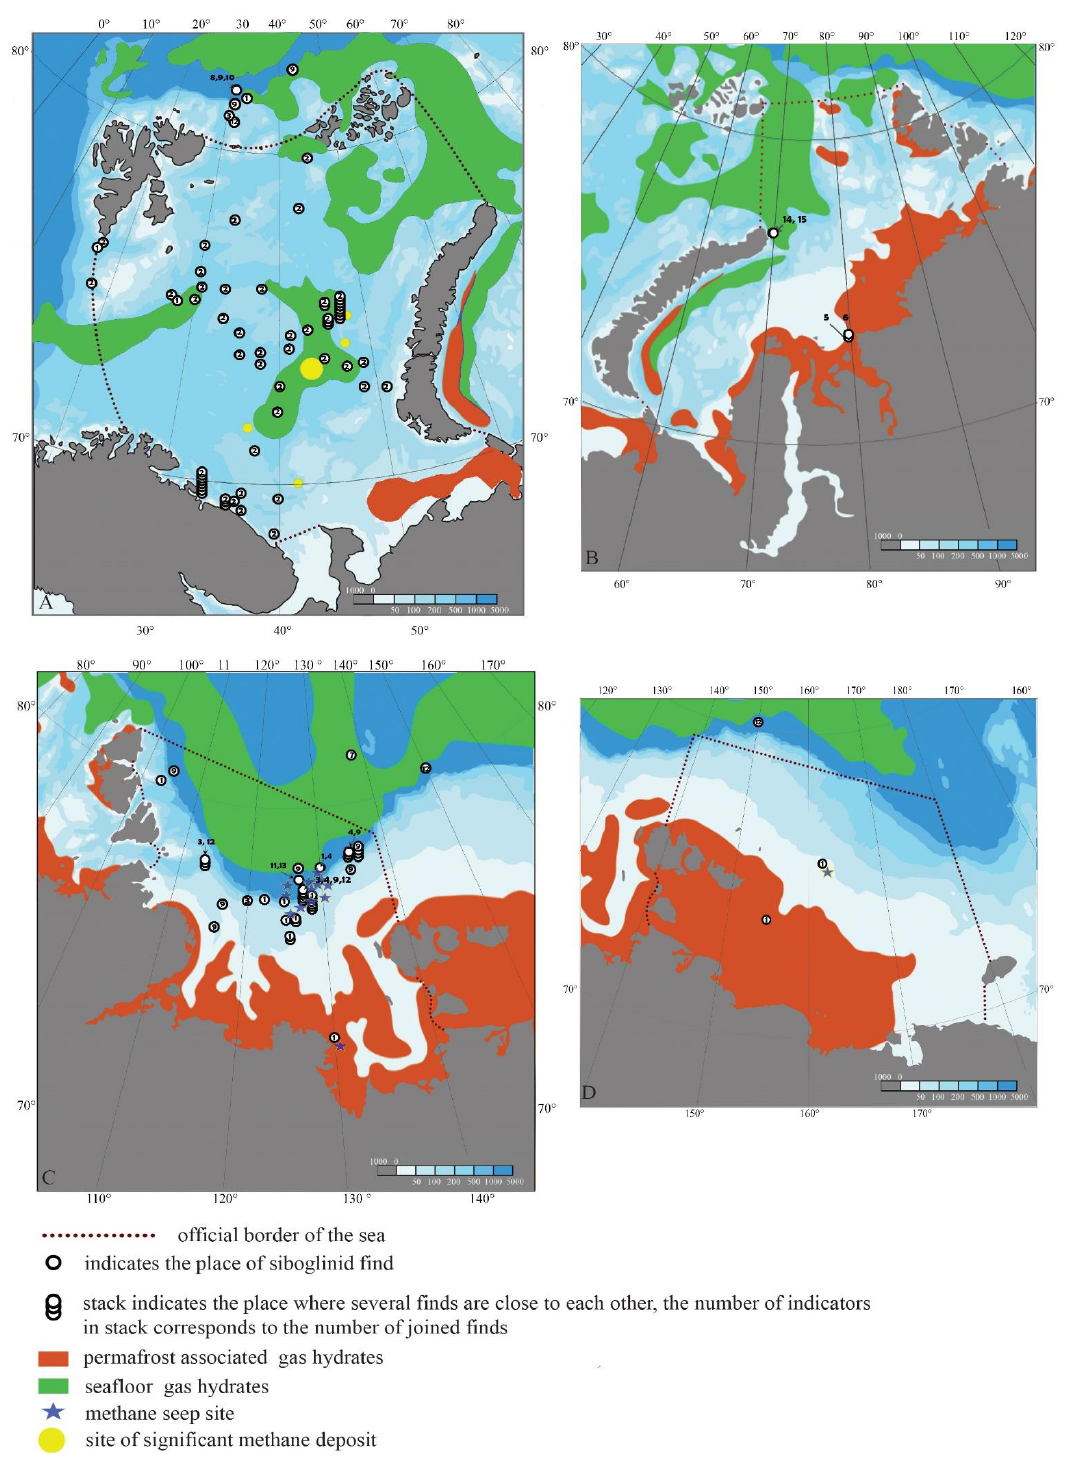
Figure 6. Distribution map of siboglinid records in the Arctic seas of Russia with different methane occurrences (deposits, gas hydrates (by Solovyov et al., 1987 [98]), and methane seep sites (by Shakhova et al., 2015 [69])). ( A )—the Barents Sea, ( B )—the Kara Sea, ( C )—the Laptev Sea, ( D )— the East-Siberian Sea. The numbers indicate the records of the following siboglinid species: 1— Oligobrachia haakonmosbiensis , 2— Nereilinum murmanicum , 3— Nereilinum squamosum , 4— Polarsternium rugellosum , 5— Crispabrachia yenisey , 6— Galathealinum karaense , 7— Polybrachia gorbunovi , 8— Siboglinum ekmani , 9— Siboglinum hyperboreum , 10— Siboglinum norvegicum , 11— Siboglinum sp., 12— Sclerolinum contortum , 13— Siboglinidae sp. 1, 14— Siboglinidae sp. 2, 15— Siboglinidae sp.